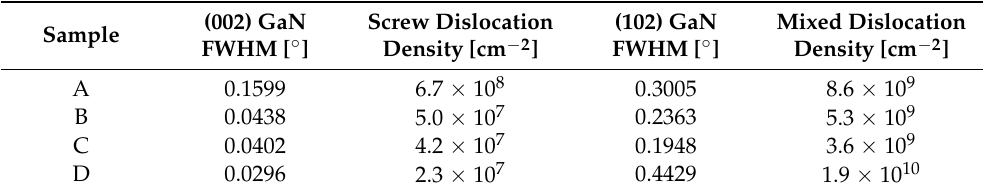
Figure 2. XRD measurements along the (002) axis and (102) axis for Sample A ( a ), Sample B ( b ), Sample C ( c ), and Sample D ( d ), respectively. Table 2. The FWHMs of (002) and (102) XRD curves for each sample, and their correspondingly calculated dislocation densities.